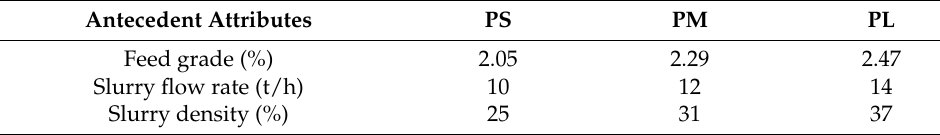
Table 1. Input referential values of antecedent attributes in gold